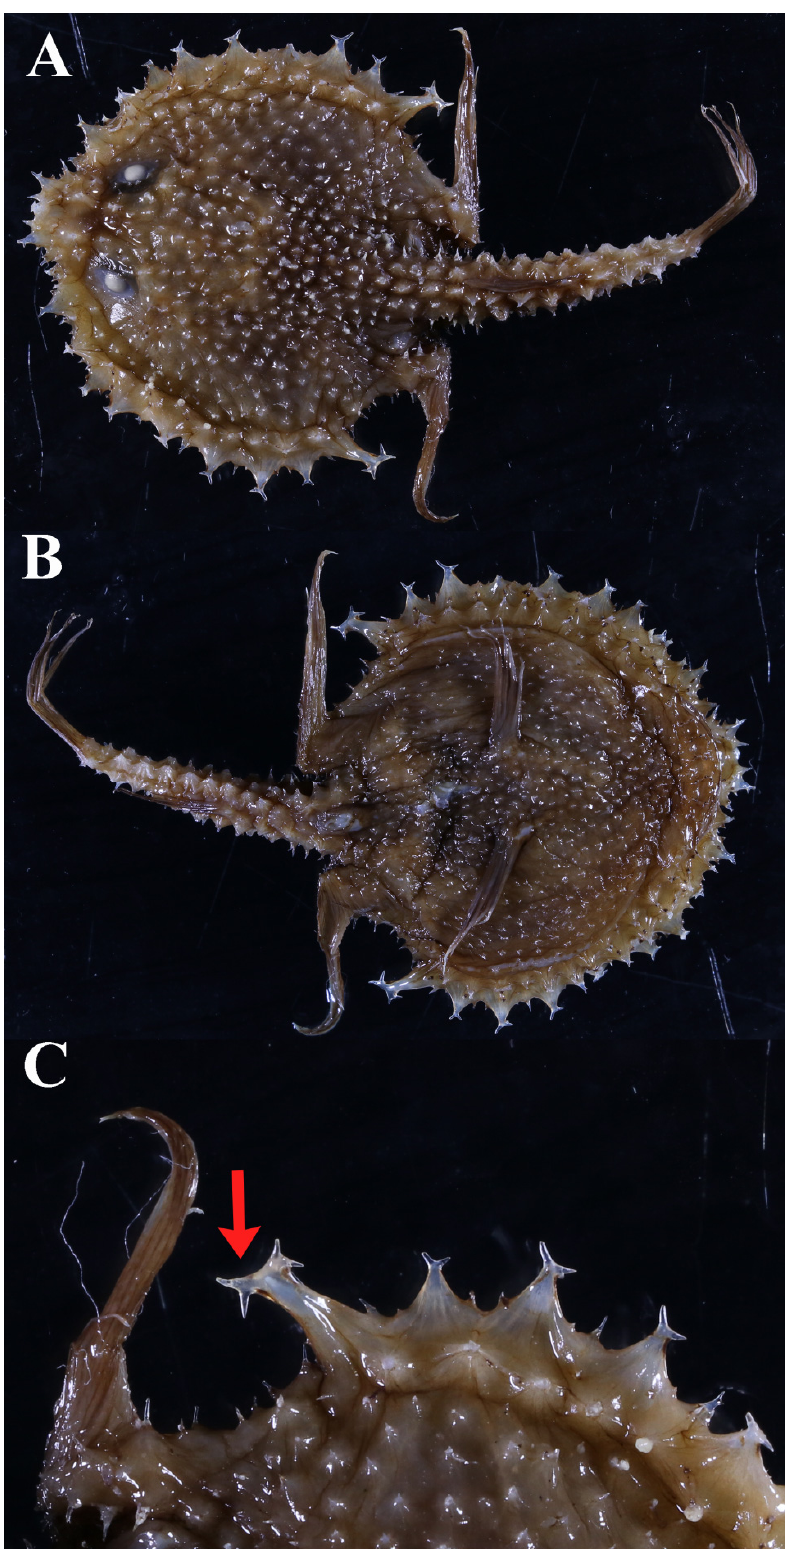
Figure 18. Halieutopsis murrayi sp. nov., holotype, BMNH 1939.5.24.1912, 48.7 mm SL. ( A ). Dorsal view. ( B ). Ventral view. ( C ). Dorsal view of left disk margin, with arrow indicating subopercular tubercle.